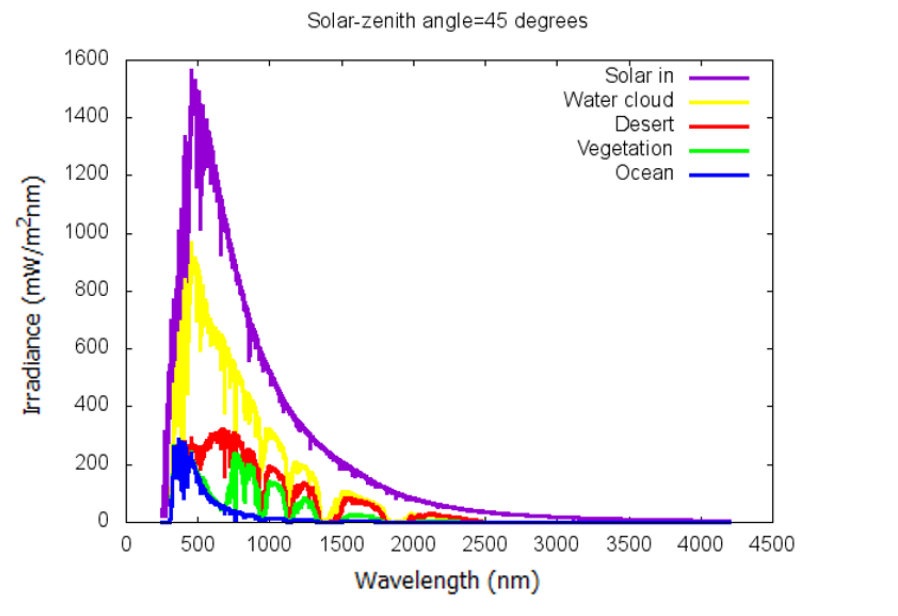
Figure 7. Simulated outgoing spectral fluxes for a solar-zenith angle of 45° and reference scenes ocean, vegetation, desert and water cloud. Differences between these scenes are notable. The ocean scene has a peak below 500 nm, while the desert scene has a peak around 700 nm and vegetation has a peak above 700